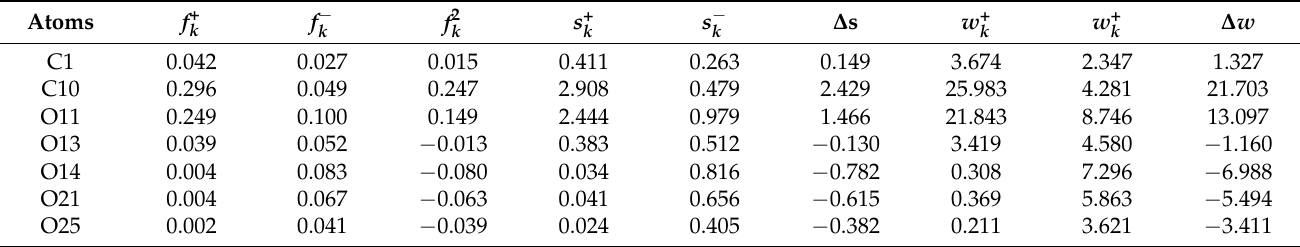
Figure 9. Condensed Fukui indices and the dual local descriptors (all values are in Hartree) of the TGP inhibitory resin. For the condensed Fukui functions: Open red and orange squares correspond to f − , filled blue circles correspond to f + . For dual descriptors: Filled green squares correspond to f 2 , filled red squares correspond to ∆ s k and blue x marks correspond to ∆ w k . Table 7. Fukui functions and the dual local descriptors.